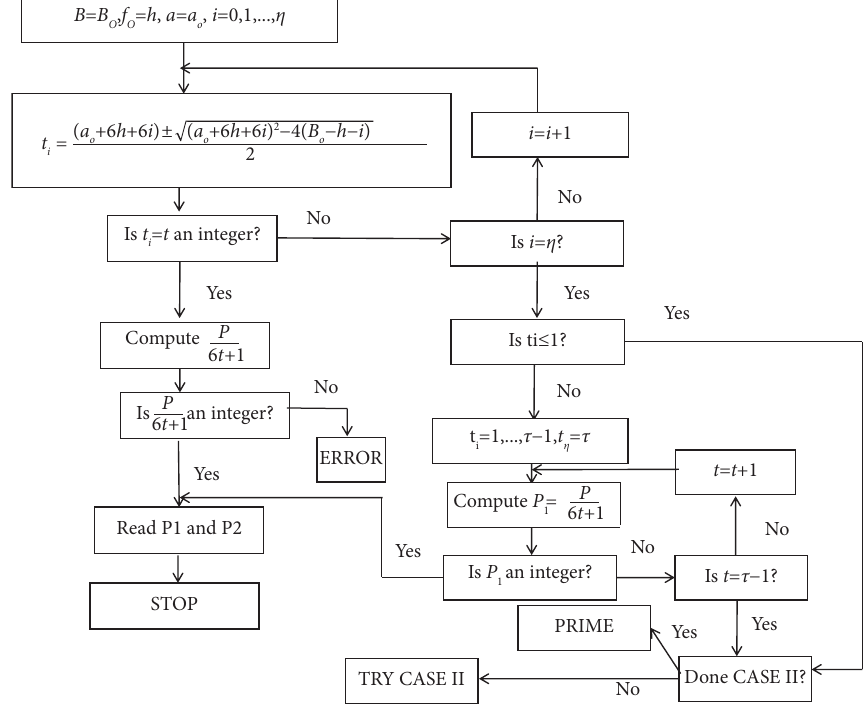
Figure 1: Algorithm for numbers of the form 6 k +1: Case